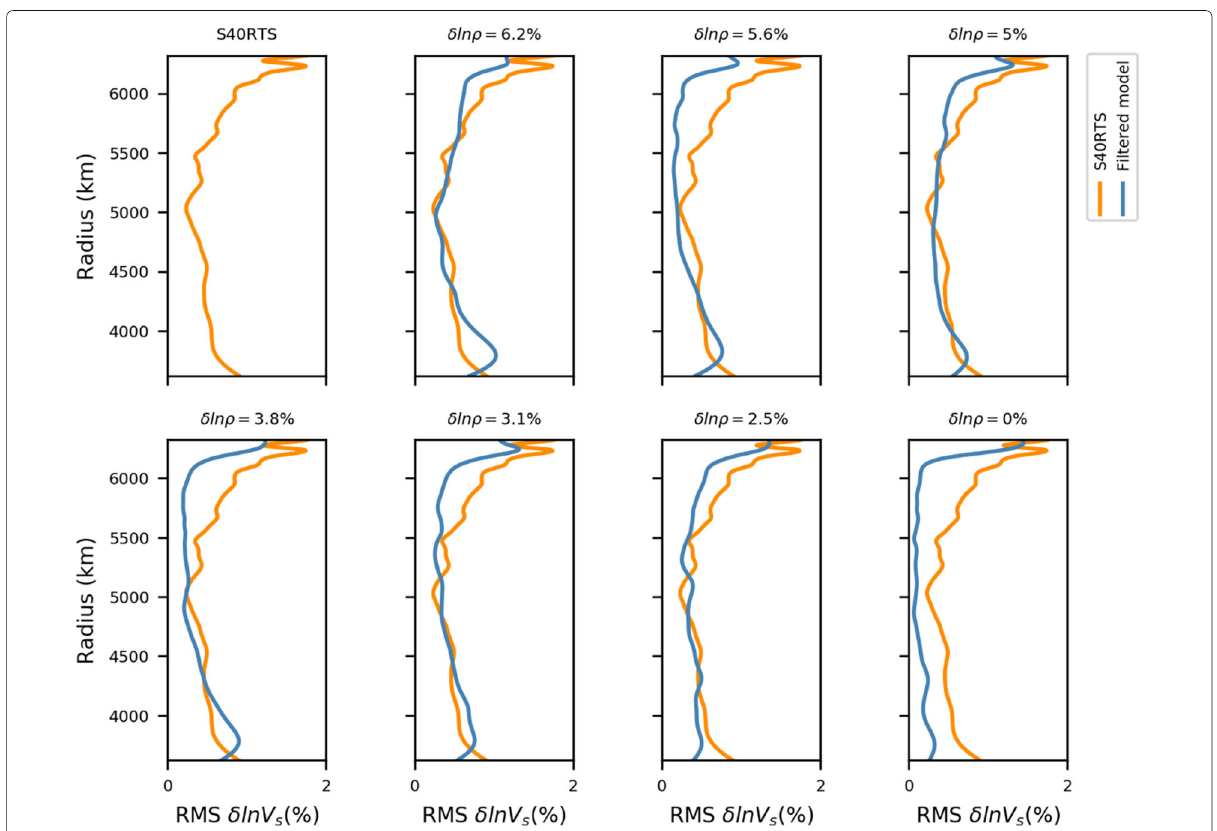
Fig. 8 RMS δ lnV s as a function of radius for S40RTS slices (orange) and dynamic models (blue) after tomographic filtering beneath the Pacific plate. RMS δ lnV s is poorly matched for all models in the upper mantle. When δρ ≥ 3.1%, the amplitude of RMS δ lnV s in the lower mantle can be matched except for the small inflection at the CMB. Overall, RMS δ lnV s is smoother for the filtered models than for S40RTS